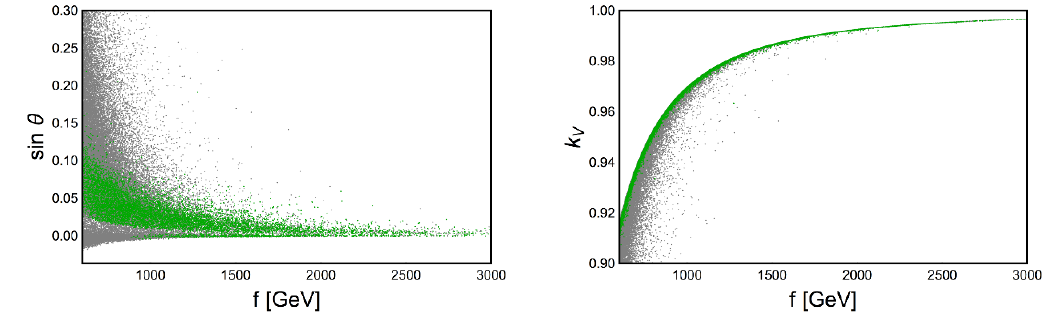
Figure 8 . Here, we show sin (cid:18) (left) and k V (right) as a function of f . The green(gray) points (do not) satisfy the constraints from current indirect and direct Higgs